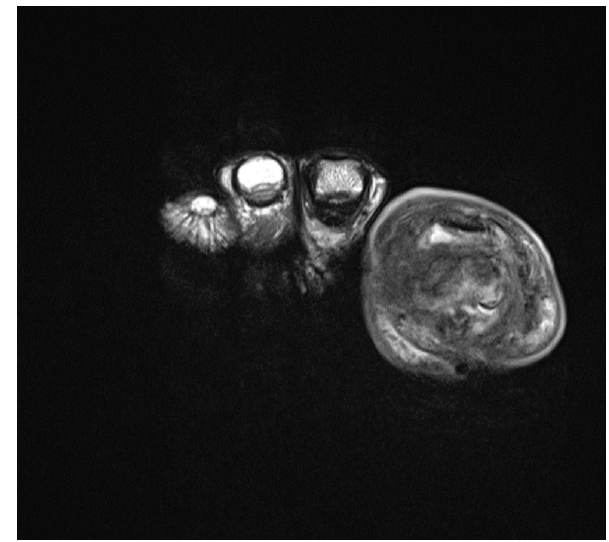
Figure 3. T2-weighted images of the same view as in Fig.